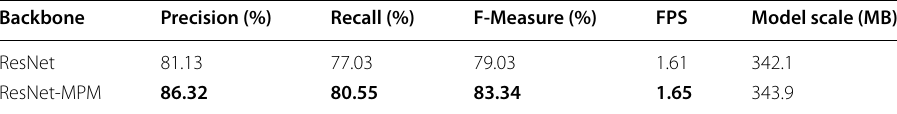
Table 1 Performance comparison of the MPM on the backbone network. "MPM" means adding mixed pooling to the ResNet network, and bold indicates that it ranks first in related performance Backbone Precision (%) Recall (%) F-Measure (%) FPS Model scale (MB) ResNet 81.13 ResNet-MPM